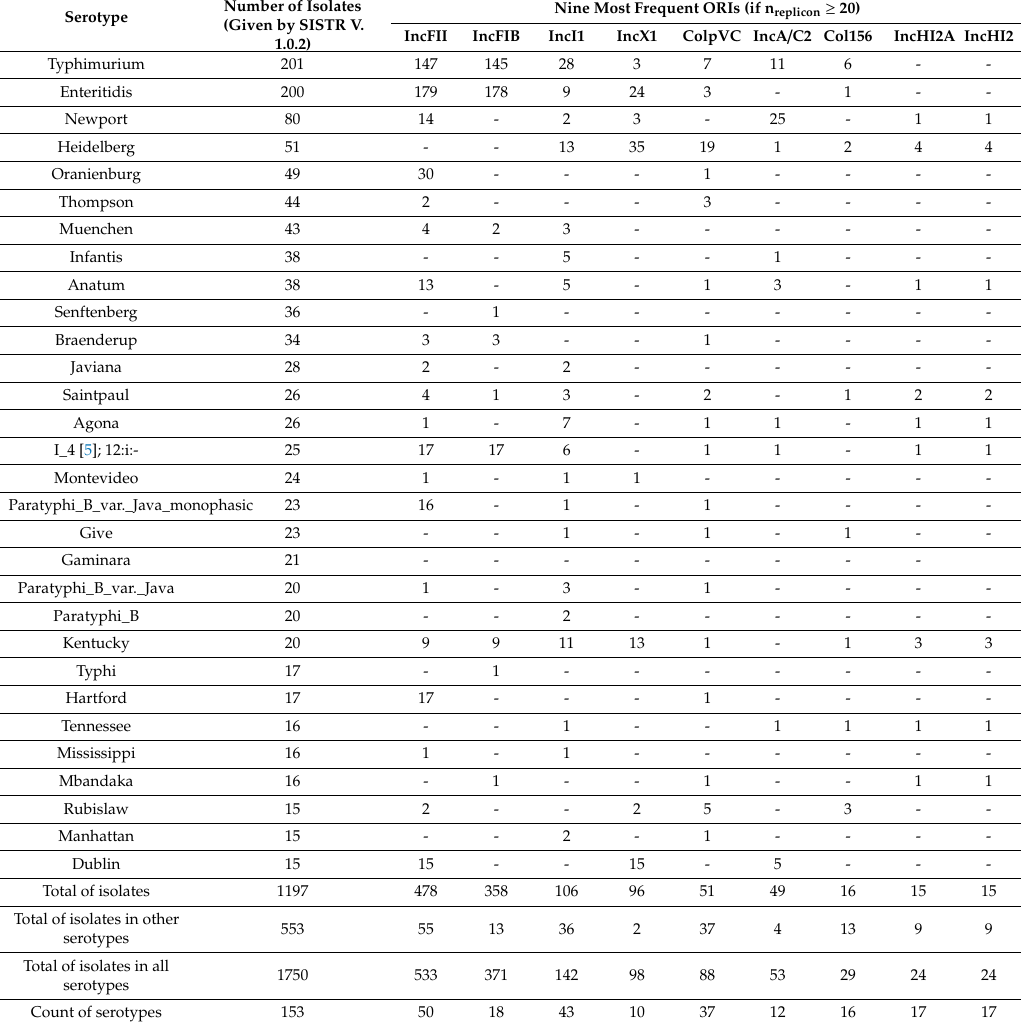
Table 1; the three most widespread ORIs between Salmonella serotypes were IncFII (n serotype = 50), IncI1 (n serotype = 43), and ColpVC (n serotype = 37). In contrast, the two ORIs, IncX1 (n serotype = 10) and IncA / C2 (n serotype = 12), were limited to few serotypes (Table 1). Table 1. Nine most frequent ORIs found across the most frequent S. enterica serotypes. Number of Isolates Serotype (Given by SISTR V. 1.0.2)